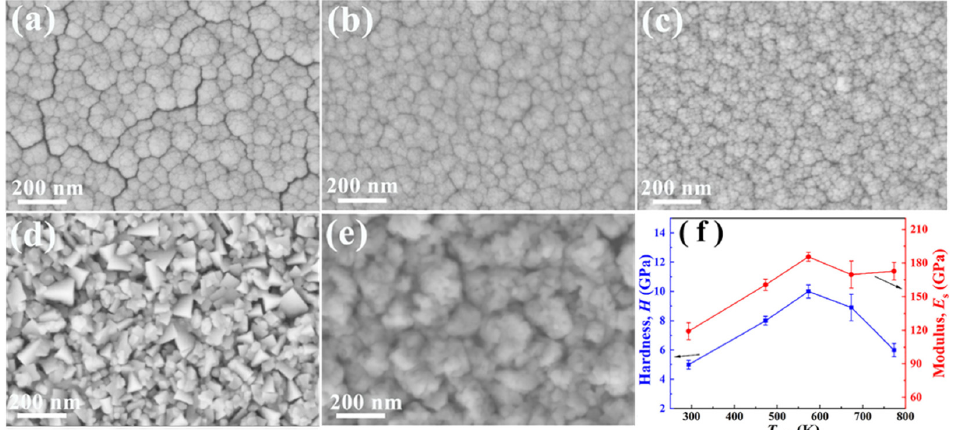
Figure 5. Surface morphology of HEA thin film FeCoNiCrMn at different substrate temperatures, ( a ) 293 K, ( b ) 473 K, ( c ) 573 K, ( d ) 673 K, and ( e ) 773 K. ( f ) The hardness and elastic modulus of FeCoNiCrMn films as a function of substrate temperatures [60].